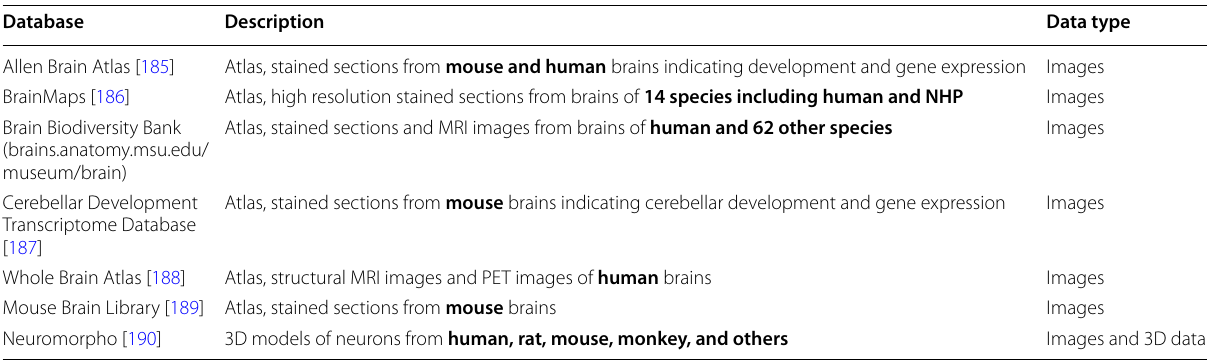
Table 3 Open database in neuroscience, which contains multiple species as highlighted in bold